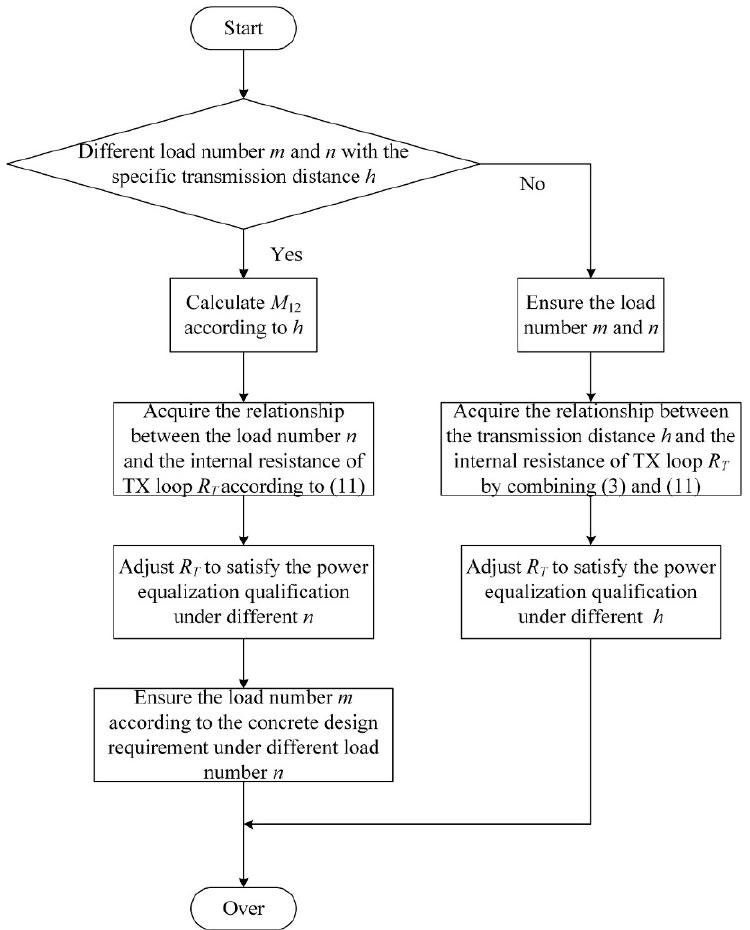
Figure 9. Flow chart of the adjustment of R T according to different transmission distances and load numbers.